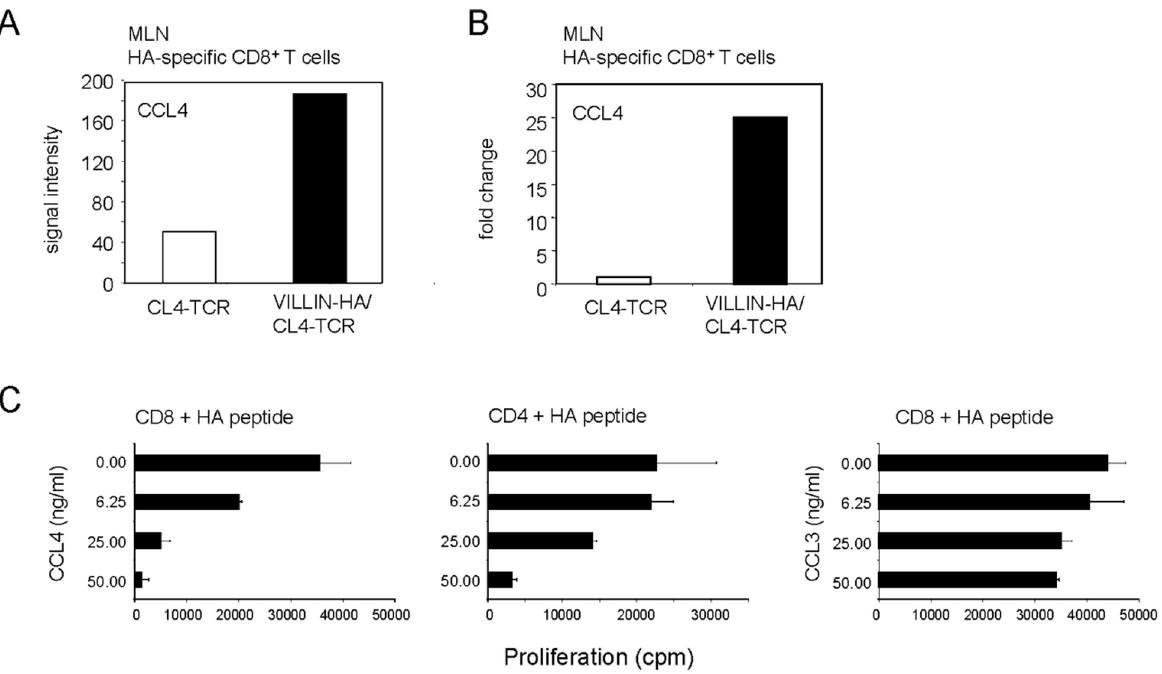
Figure 4. Specific expression of CCL4 by HA-specific CD8 + T cells from VILLIN-HA/CL4-TCR transgenic mice. (A) CD8 + H- 2K d IYSTVASSL + were sorted from the MLN of CL4-TCR and VILLIN-HA/CL4-TCR transgenic mice. Affymetrix gene chip experiments were performed and analyzed for the expression of CCL4. Expression of CCL4 is indicated as signal intensity. (B) CD8 + H-2K d IYSTVASSL + T cells were isolated from the MLN of CL4-TCR and VILLIN-HA/CL4-TCR transgenic mice by cell sorting. CCL4 expression was assayed by quantitative PCR and normalized relative to expression of RPS9. Data shown are representative of three independent experiments. (C) HA-specific CD4 + T cells (TCR- HA) and HA-specific CD8 + T cells (CL4-TCR) were stimulated with the corresponding antigen in the presence of indicated concentrations CCL4 or CCL3. Proliferation was measured by [ 3 H]thymidine incorporation. One representative experiment out of three independent experiments is shown.